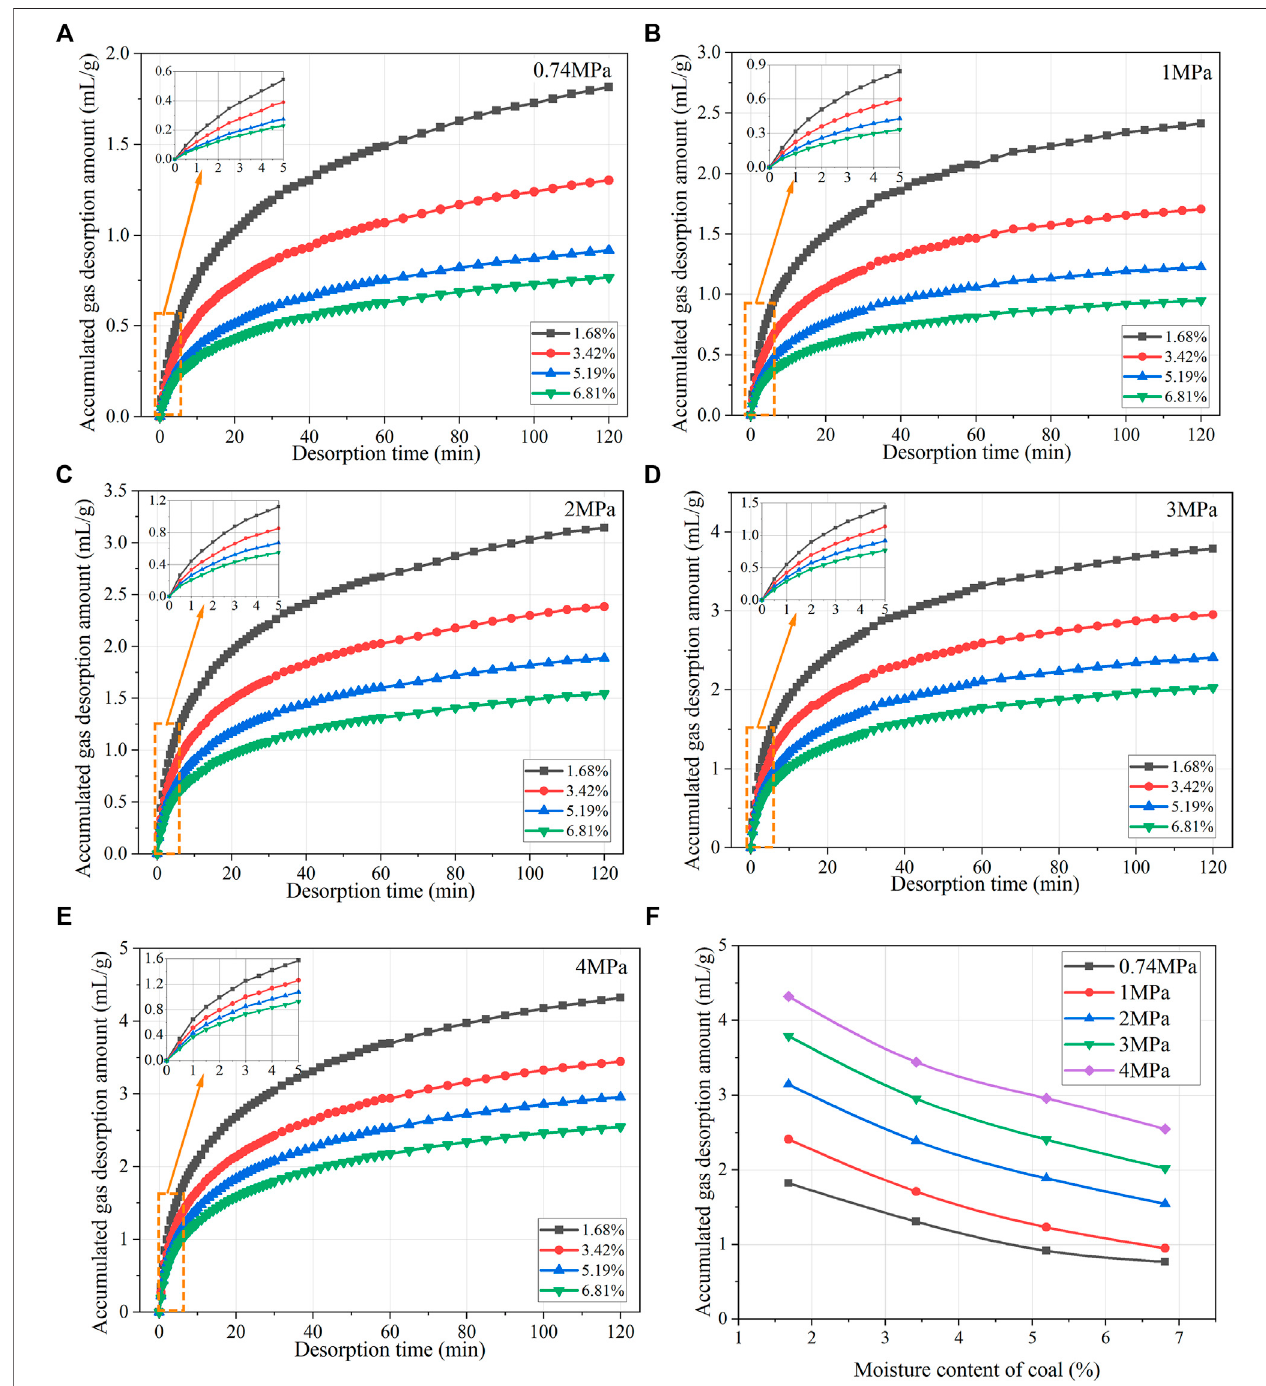
FIGURE 4 | Gas desorption curves of coal samples with different moisture content at different adsorption equilibrium pressure. (A) Equilibrium pressure of 0.74 MPa. (B) Equilibriumpressureof1 MPa. (C) Equilibriumpressureof2 MPa. (D) Equilibriumpressureof3 MPa. (E) Equilibriumpressureof4 MPa. (F) Accumulated gas desorption